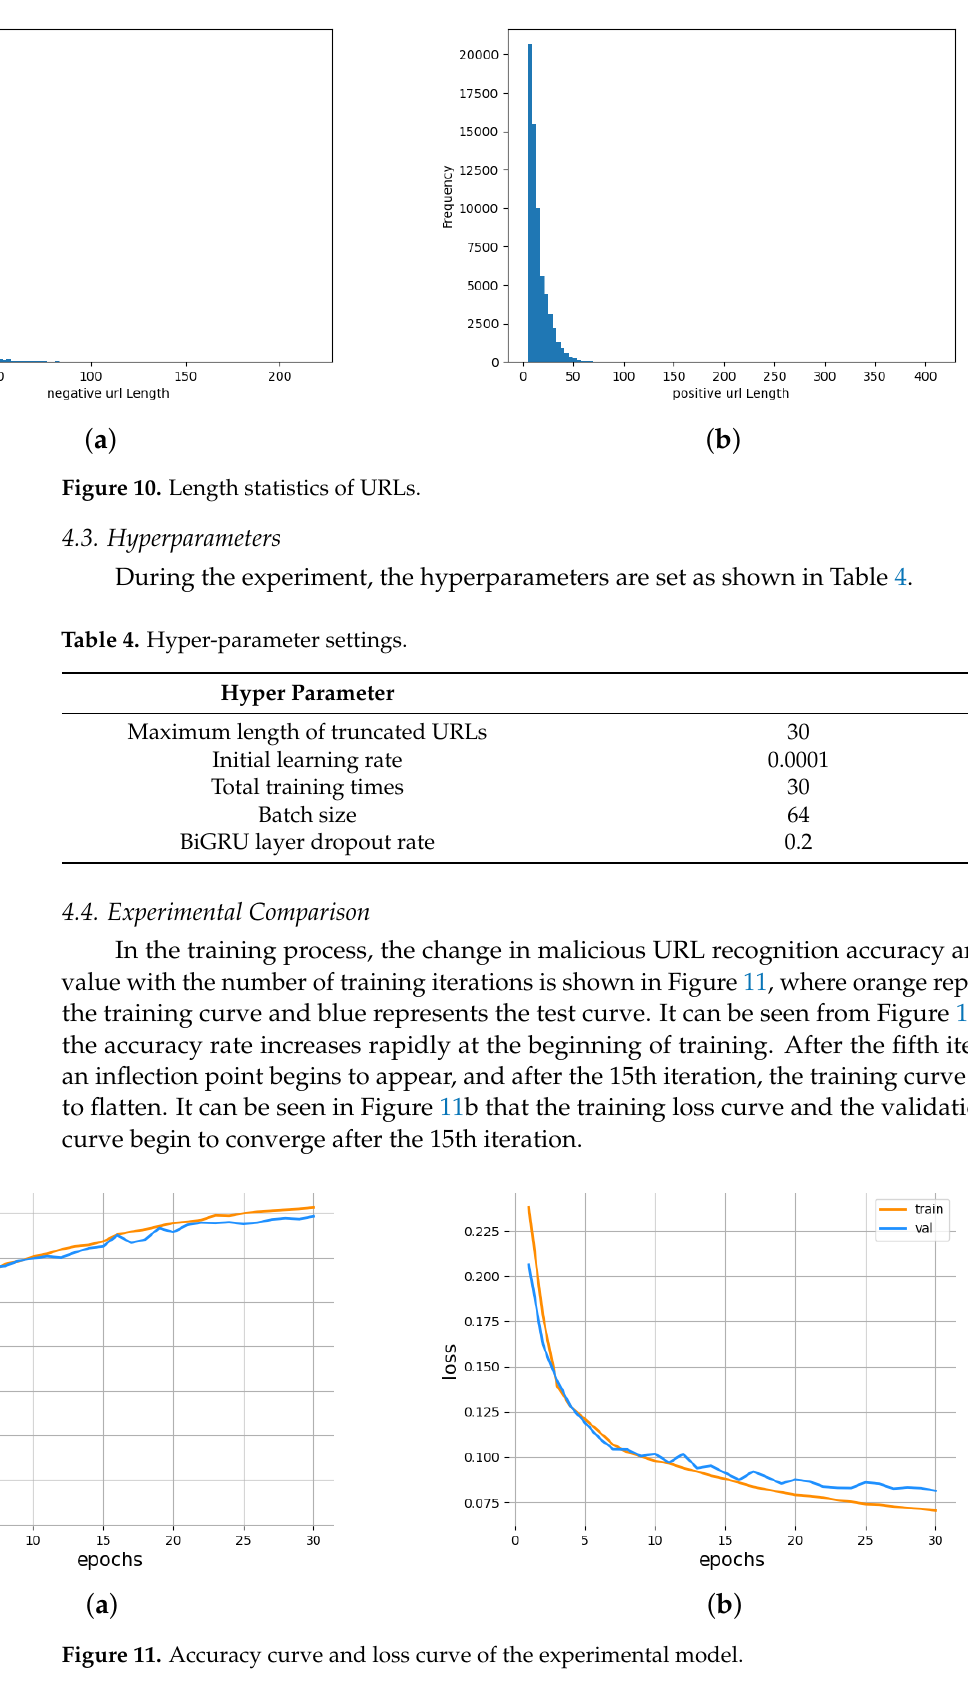
Figure 11. Accuracy curve and loss curve of the experimental model. Figure 12 is the ROC curve of the experimental model. By observing the ROC curve, the area under curve (AUC) is close to 1, indicating that the DA-BiGRU model has good classification effect. MLP is the starting point for studying more complex deep learning methods. GRU is a variant of LSTM, which is simplified compared with the internal structure of LSTM, and the accuracy is also improved. Therefore, this paper selects four models of MLP, Att-BiLSTM,